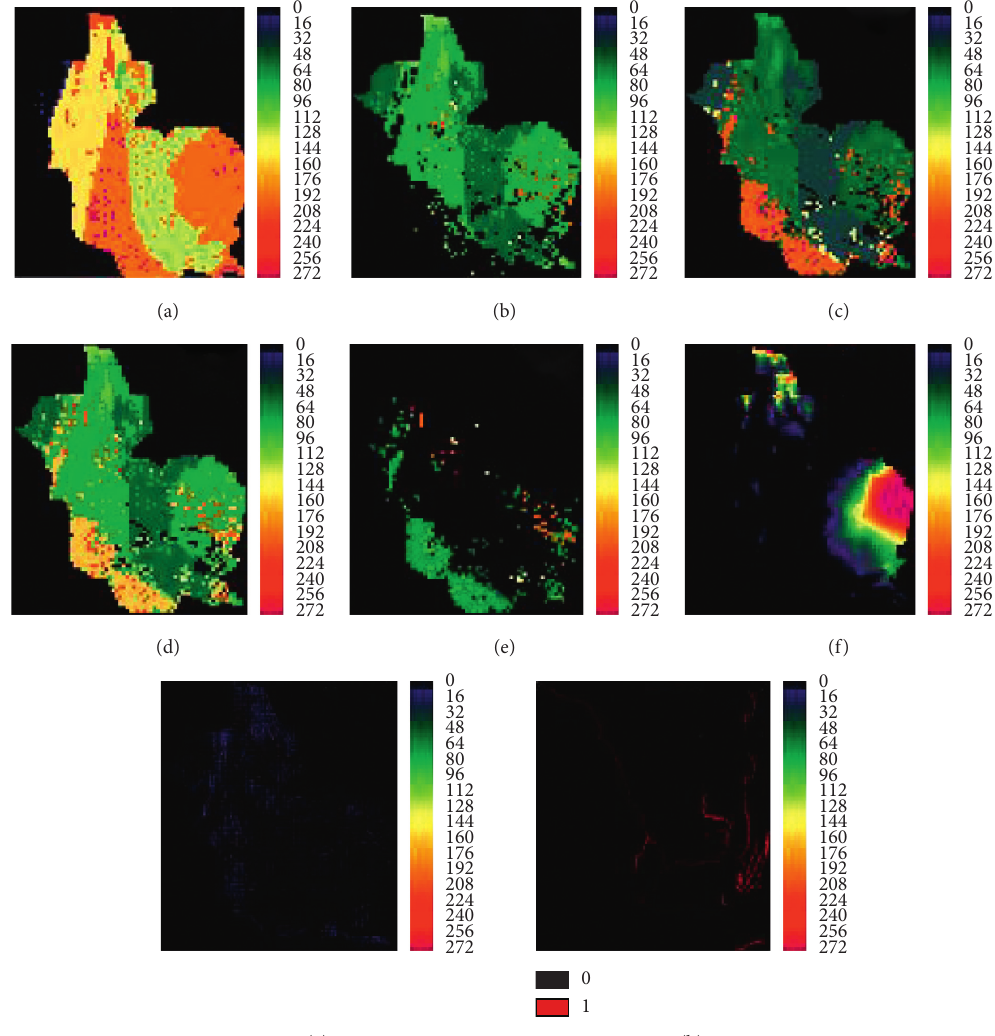
Figure 3: The suitability maps and input data: forestland (a), farmland (b), grassland (c), settlement (d), and waterbody (e) are suitability maps. Elevation (f), slope (g), and road (h) are the input